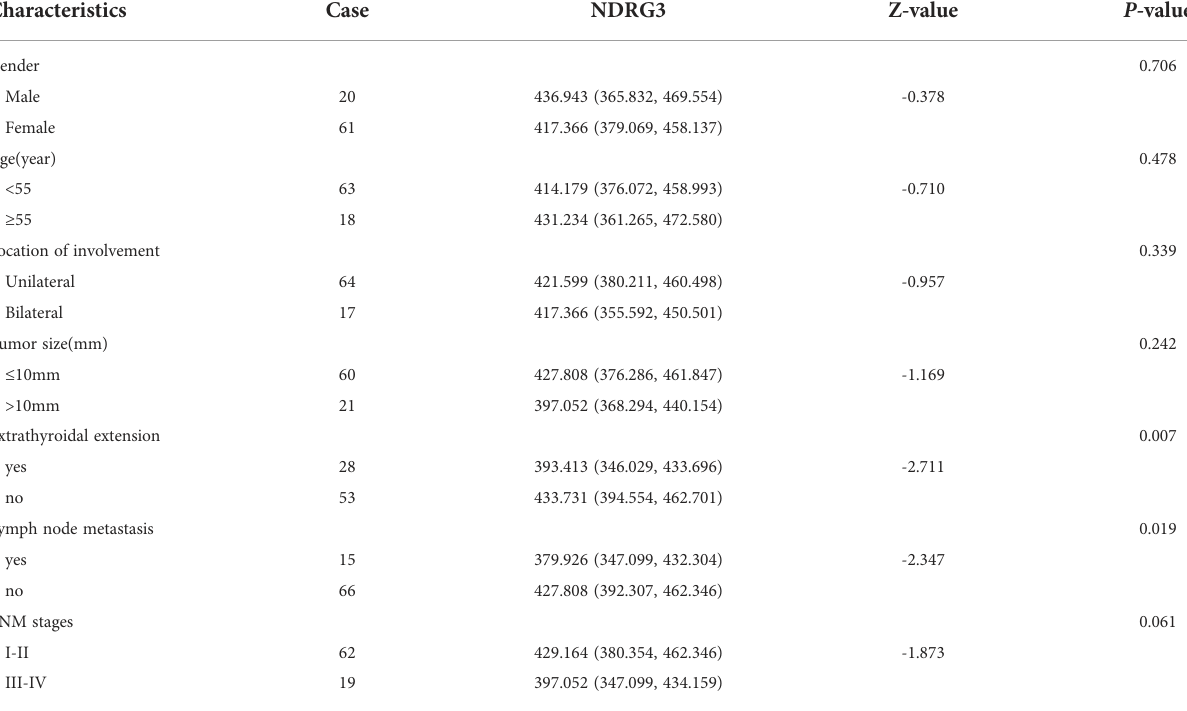
TABLE 3 Relationship between NDRG3 and clinical parameters of patients with PTC.